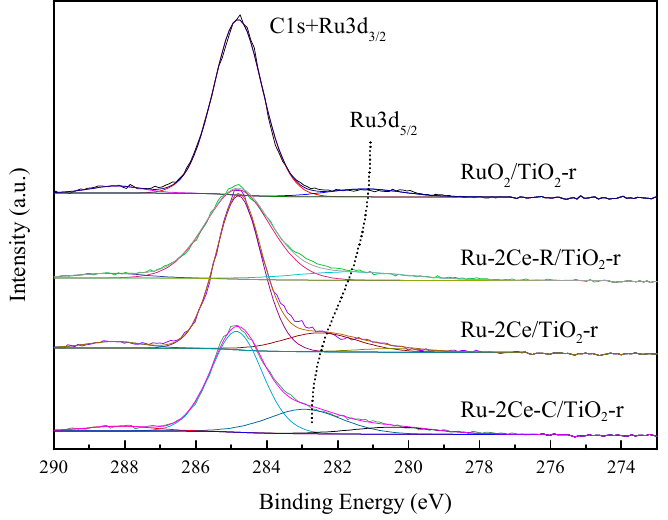
Figure 7. XPS spectra and peak fitting curves of Ru 3d of the supported RuO 2 and Ru-Ce/Ti oxide catalysts.